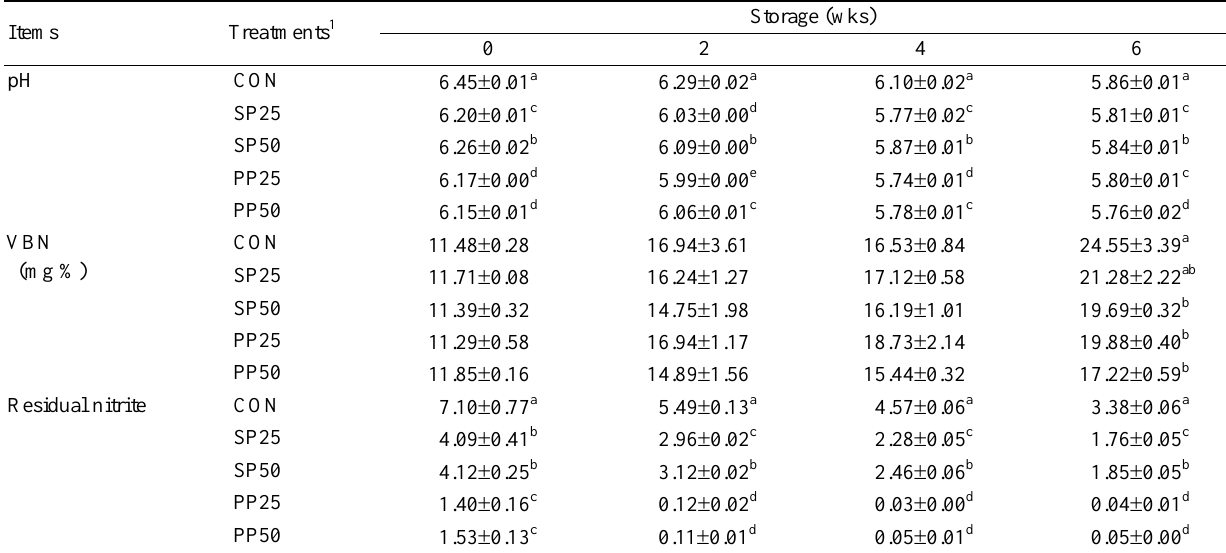
Table 3. Hydrogen ion concentration (pH), volatile basic nitrogen (VBN), and residual nitrite of cooked pork sausages containing two different percentages of purple sweet potato combined with nitrite during 6 wks of storage at 4 